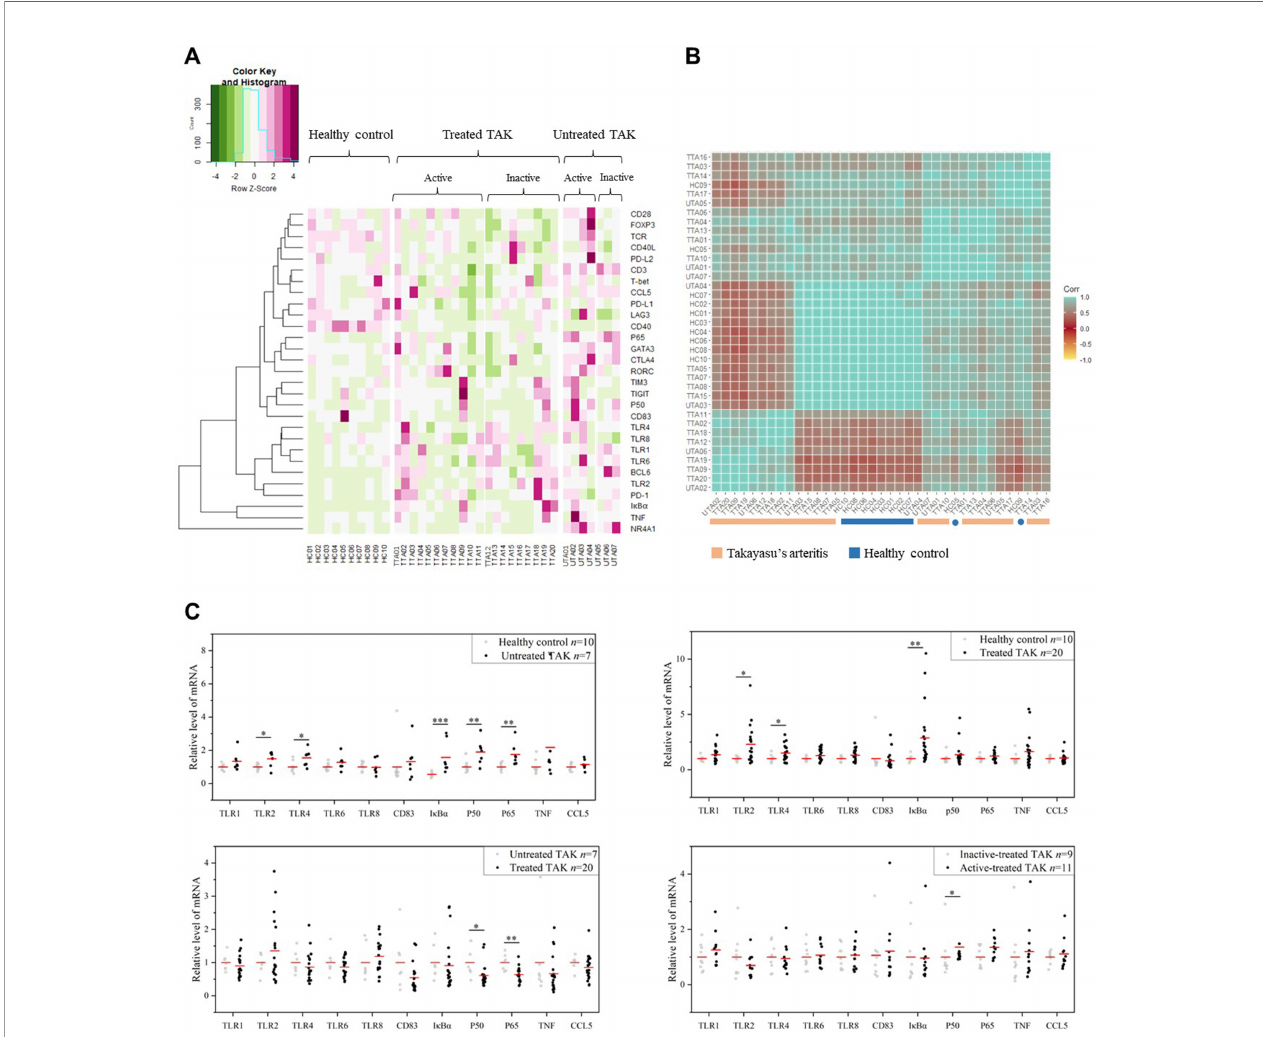
FIGURE 3 | The gene expression levels. (A) The heatmap showing gene expression levels with corresponding dendrograms using hierarchical clustering (Euclidean distance measure). (B) The heatmap of sample clustering using hierarchical clustering (Pearson correlation), suggesting that TAK patients had a different expression pattern of the selected genes from the healthy controls. (C) Gene expression differential analysis of TLR signaling pathway. Mann – Whitney test. * p < 0.05. ** p < 0.01, *** p < 0.001. The red center line represented the mean value of the mRNA level. TAK, Takayasu ’ s